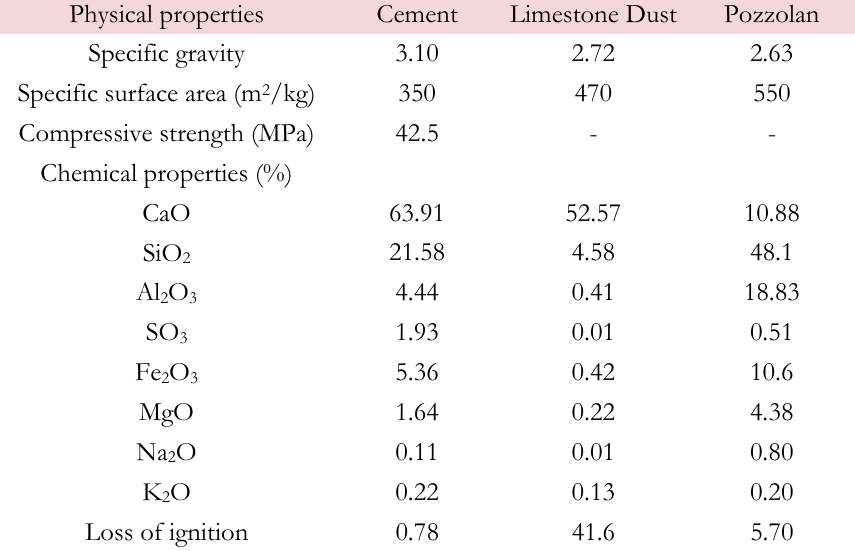
Table 1: Characteristics of ordinary cement, limestone dust and natural pozzolan.